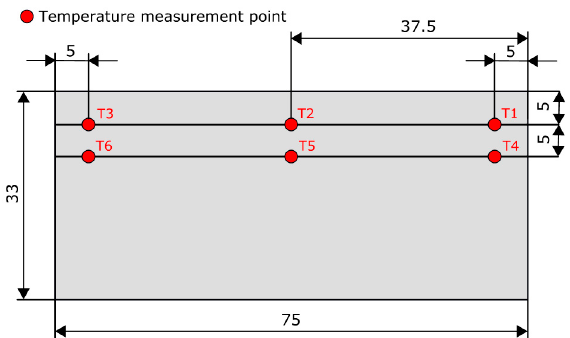
Figure 6. Arrangement of thermocouples in the workpiece cross-section.